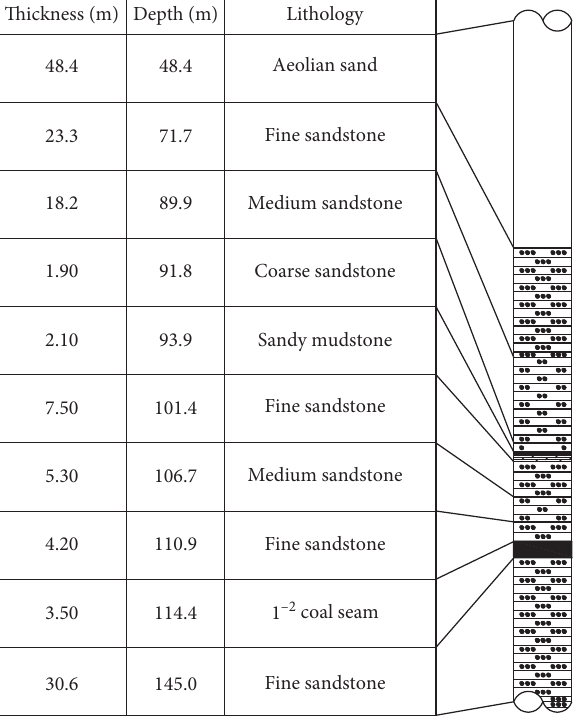
Figure 2: Comprehensive histogram.